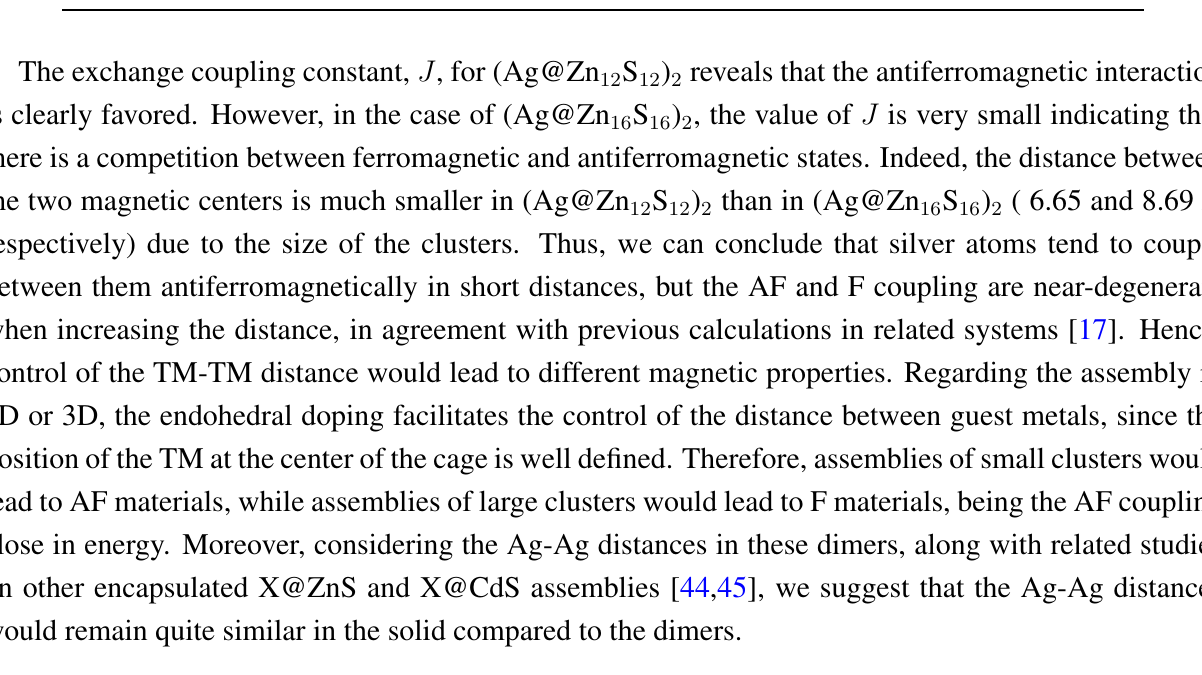
, are given in kcal/mol. J is the exchange coupling dim and < S 2 > are the spin expectation values of high spin HS BS